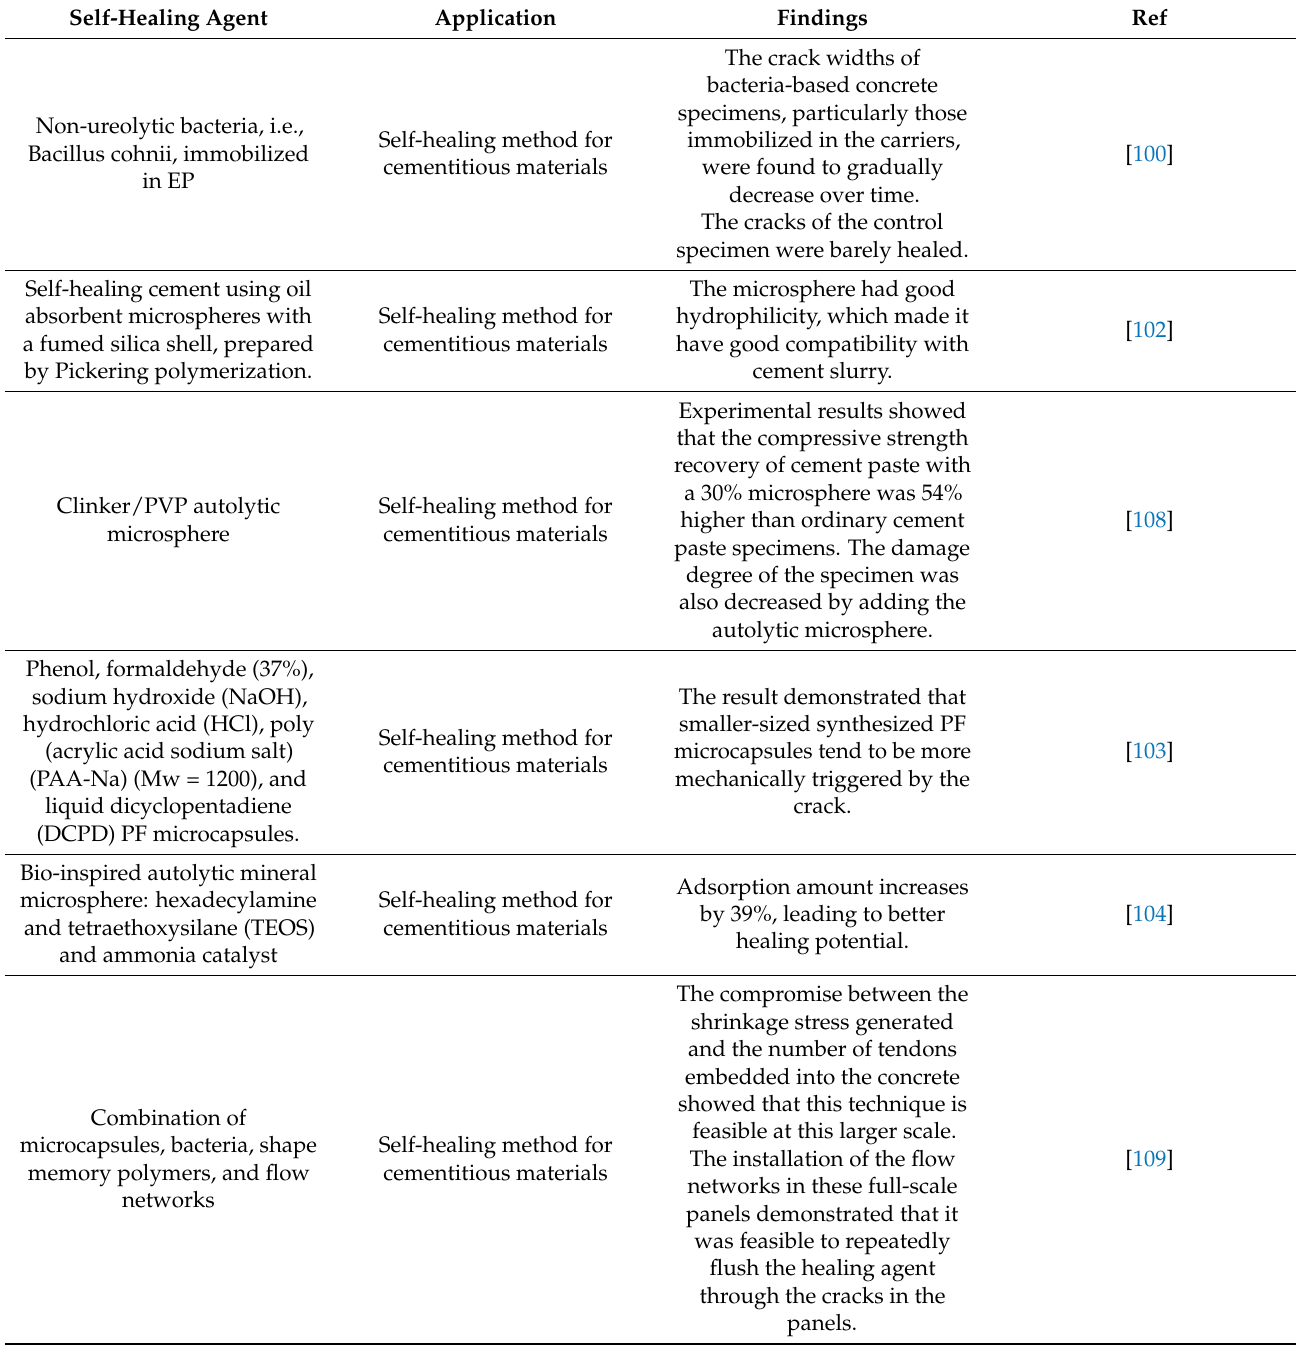
Table 5. Self-healing materials in construction